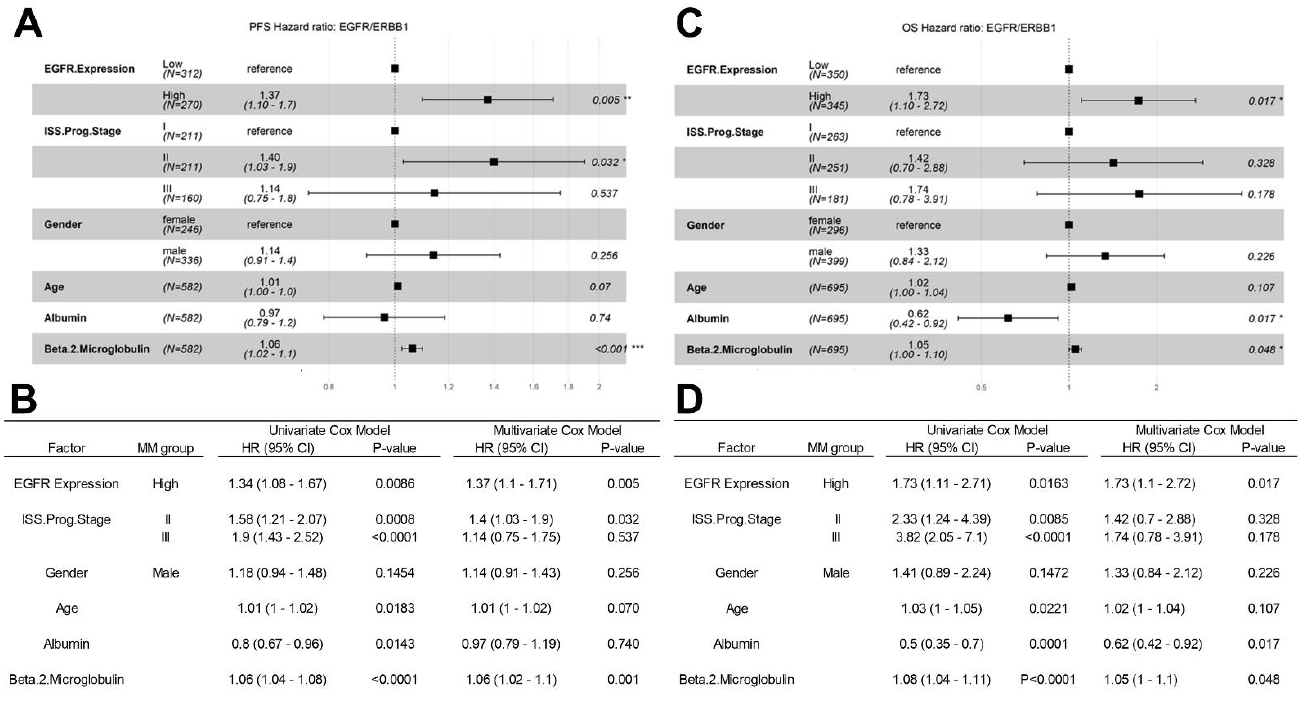
Figure 5. The unfavorable impact of high EGFR/ERBB1 expression on PFS and OS outcomes of MM patients from the MMRF-CoMMpass study in univariate and multivariate Cox proportional hazards models. ( A , B ) Comparison of the PFS times for 582 evaluable patients showed a signifi- cant increase in HR for patients with high expres-sion of EGFR/ERBB1 compared to patients with low EGFR/ERBB1 expression in the multivariate model. ( C , D ) OS relation-ships were evaluable for 695 patients). Significant p -values in B and D are indicated by *, ** and *** for p < 0.05, p < 0.01 and p < 0.001